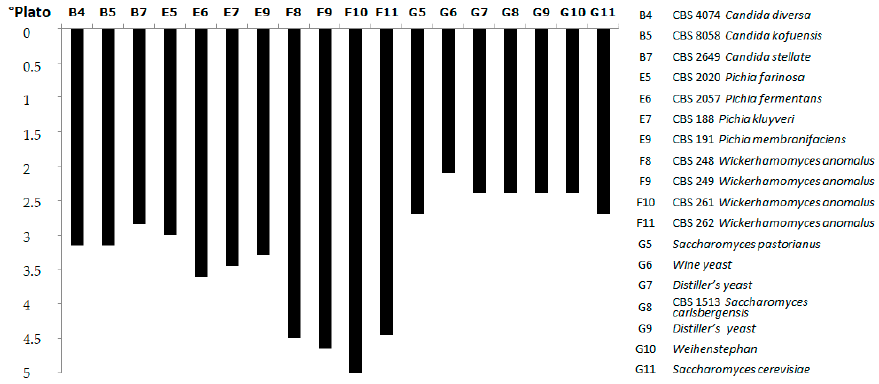
Figure 4. Final sugar content of the selected strains at the end of fermentation. Sugar concentration was measured in °P after 13 days of fermentation.